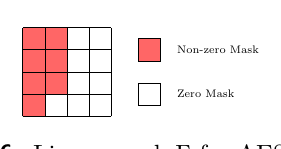
Figure 16: Linear mask Γ for AES-PRF 1 , 9 .